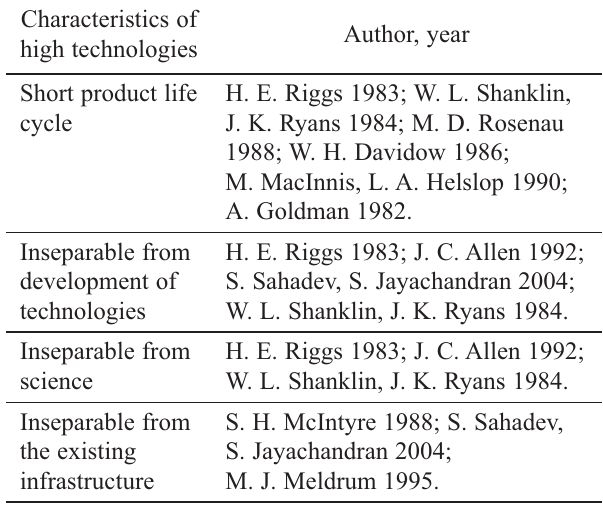
Table 1. Characteristics of high